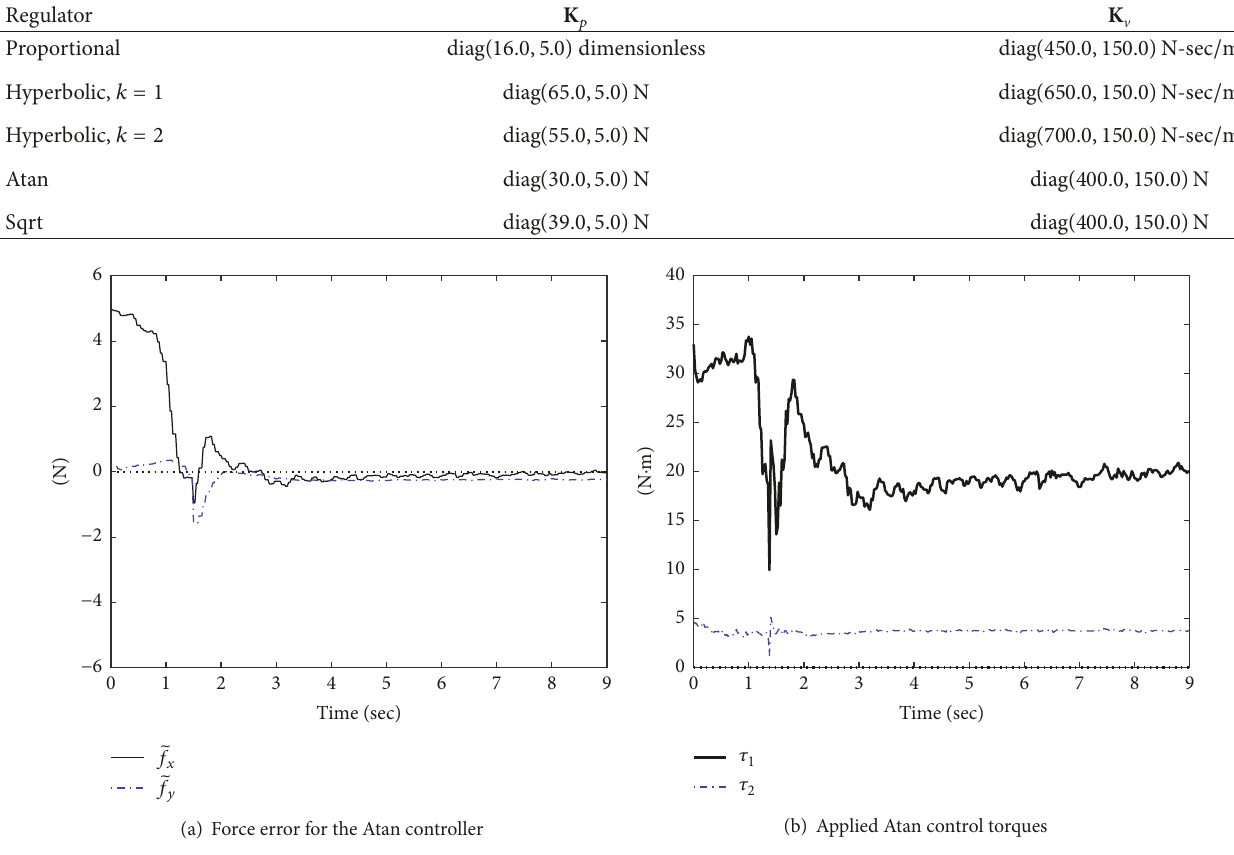
Figure 3: Experimental results for the Atan control 𝜏 Atan = J ( q ) 𝑇 f 𝜒